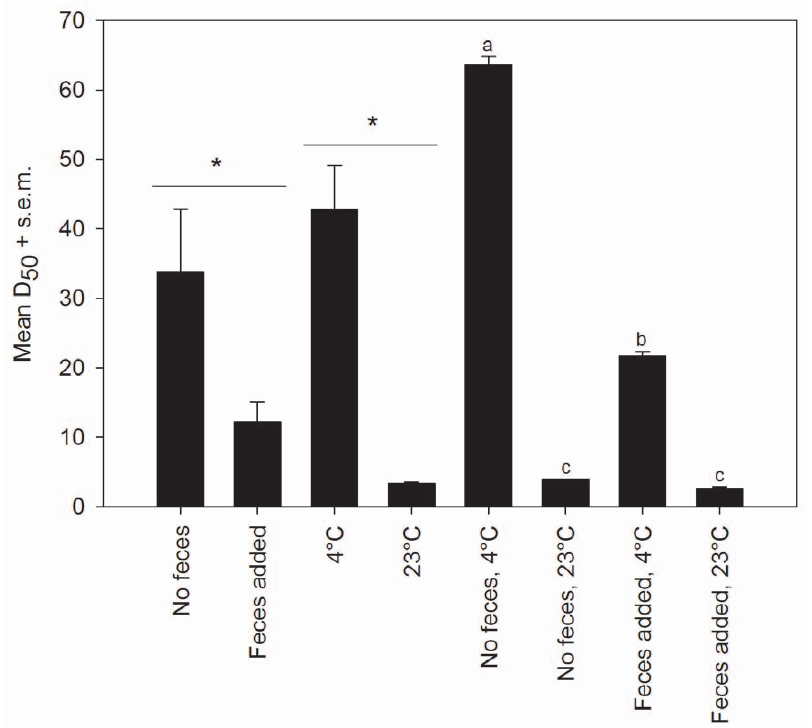
Figure 1. Ceftiofur metabolites remain biologically available in topsoil under different conditions. Effect of temperature and addition of cattle feces (1:25) on ceftiofur metabolites (CFM) as measured by recovery of growth for E. coli K-12 (D 50 ). Main effects and interactions were significant ( P , 0.0001; two-factor ANOVA). Letters designate group differences based on Tukey-Kramer multiple comparison test ( P , 0.001).